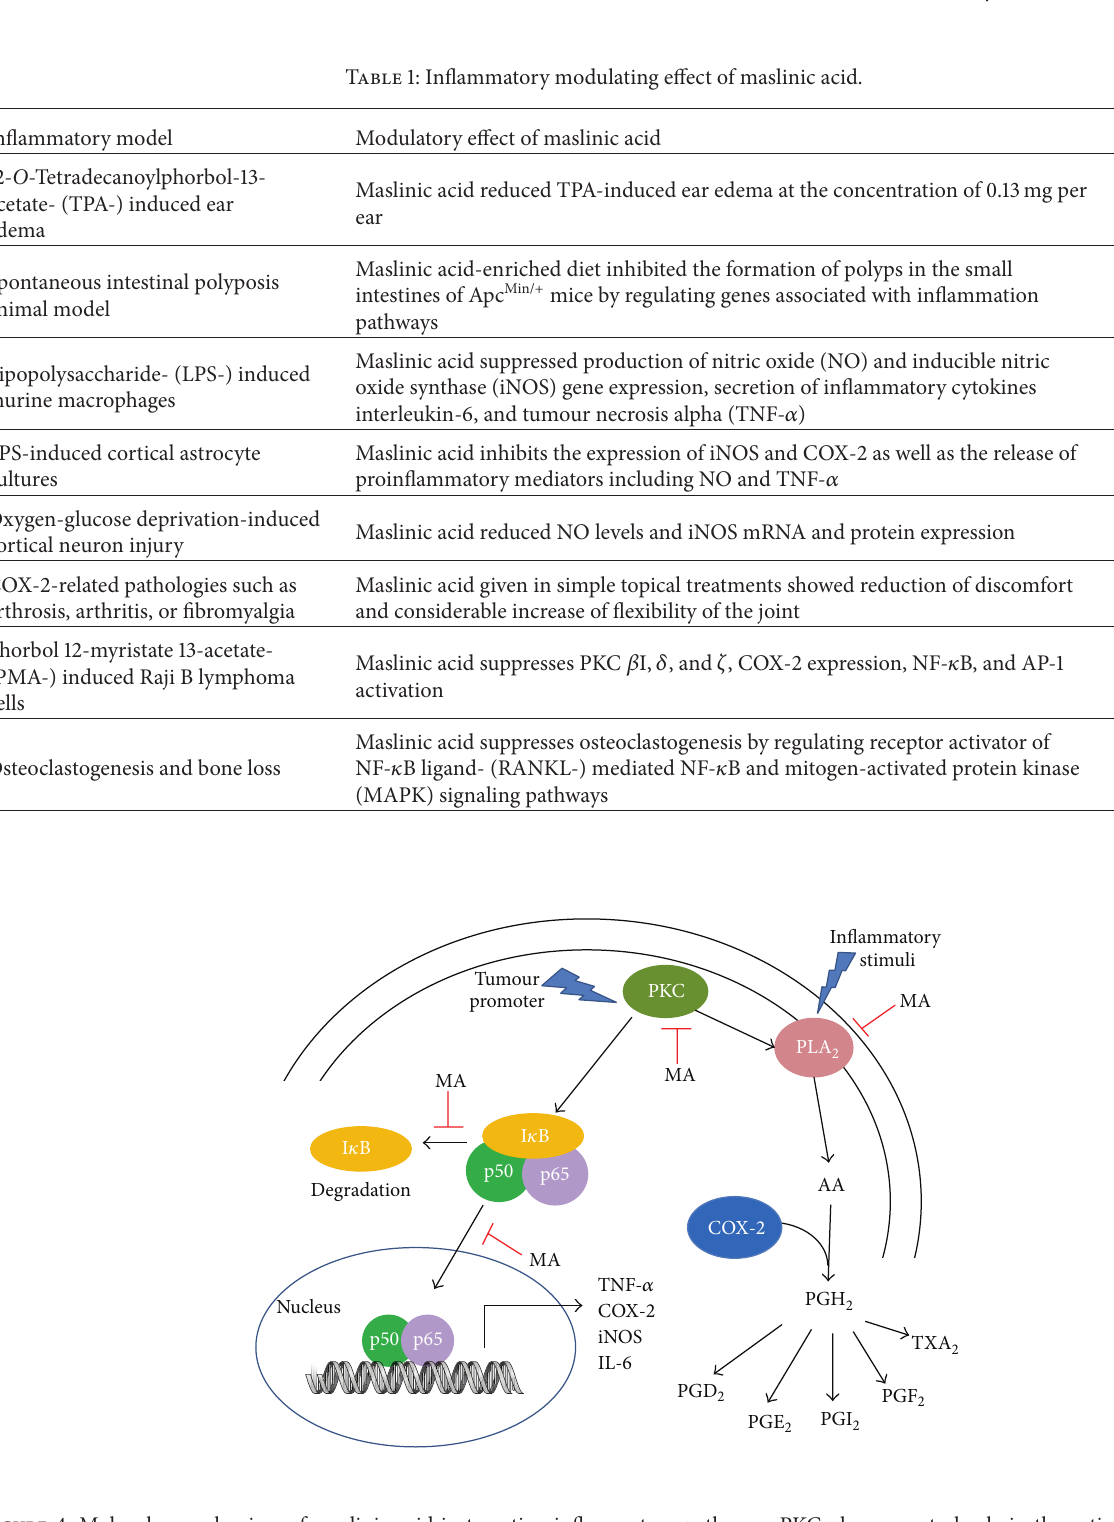
Figure 4: Molecular mechanism of maslinic acid in targeting inflammatory pathways. PKC plays a central role in the activation of NF- 𝜅 B (p50/p65). Once activated, the I 𝜅 B protein is degraded which allows NF- 𝜅 B to translocate from cytoplasm to the nucleus, where it transcribes the expression of downstream proinflammatory genes such as TNF- 𝛼 , COX-2, iNOS, and IL-6. It was shown that maslinic acid inhibited PKC activation, I 𝜅 B 𝛼 degradation, and NF- 𝜅 B nuclear translocation, which might correlate to its anti-inflammatory properties. In addition, evidence also demonstrated the role of PKC in mediating PLA 2 phosphorylation and AA release. Once released from membrane phospholipids, AA can be converted into prostanoids through the action of COX enzymes. Considering that prostanoids are important mediators of inflammation, the anti-inflammatory effect of maslinic acid may be explained through its effect in inhibiting PKC activation and/or PLA 2 enzyme activity which reduces the substrate availability for COX-2-mediated prostanoids biosynthesis in inflammatory